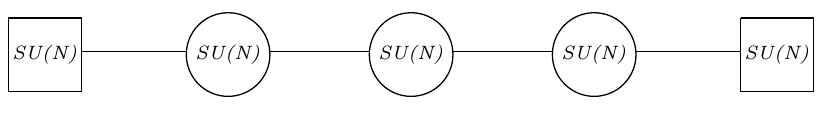
Figure 5. The quiver encoding the dynamics of our second example